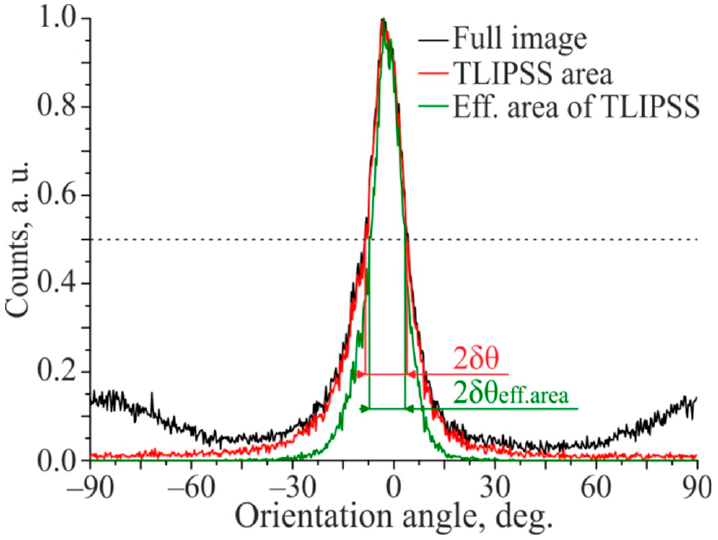
Figure A3. The ADP graphs for different areas of the TLIPSS image, formed on a hafnium film by the immobile astigmatic Gaussian beam at a power of 300 mW.